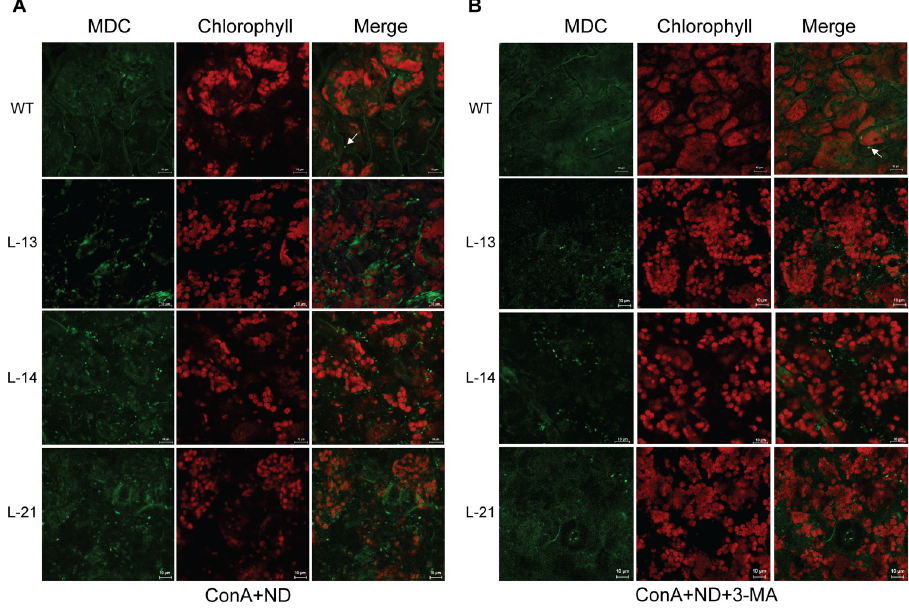
Fig 5. Overexpression of OsATG8b in Arabidopsis enhances the autophagic activity under N deficient condition. (A) 7-day-old seedlings of transgenic lines and WT were transferred to in ND liquid medium with 1 μ mol � L -1 ConA for 12h, MDC-stained autophagosomes in leaves were observed by confocal microscopy. (B) 7-day-old seedlings of transgenic lines and WT were transferred to ND liquid medium containing 1 μ mol � L -1 ConA with 5 mM 3-MA for 12h, MDC-stained autophagosomes in leaves were observed by confocal